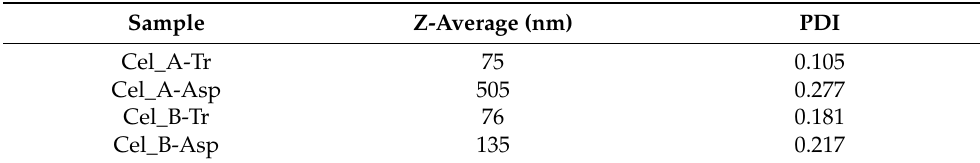
Table 4. Dispersive properties of modified